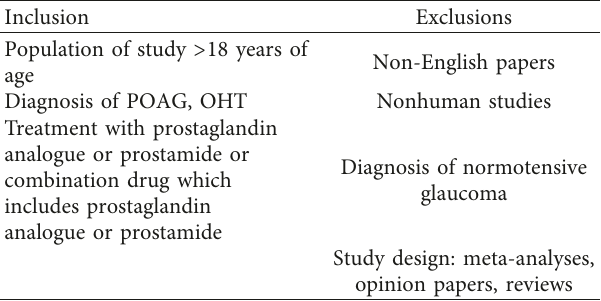
Table 1: Inclusion and exclusion